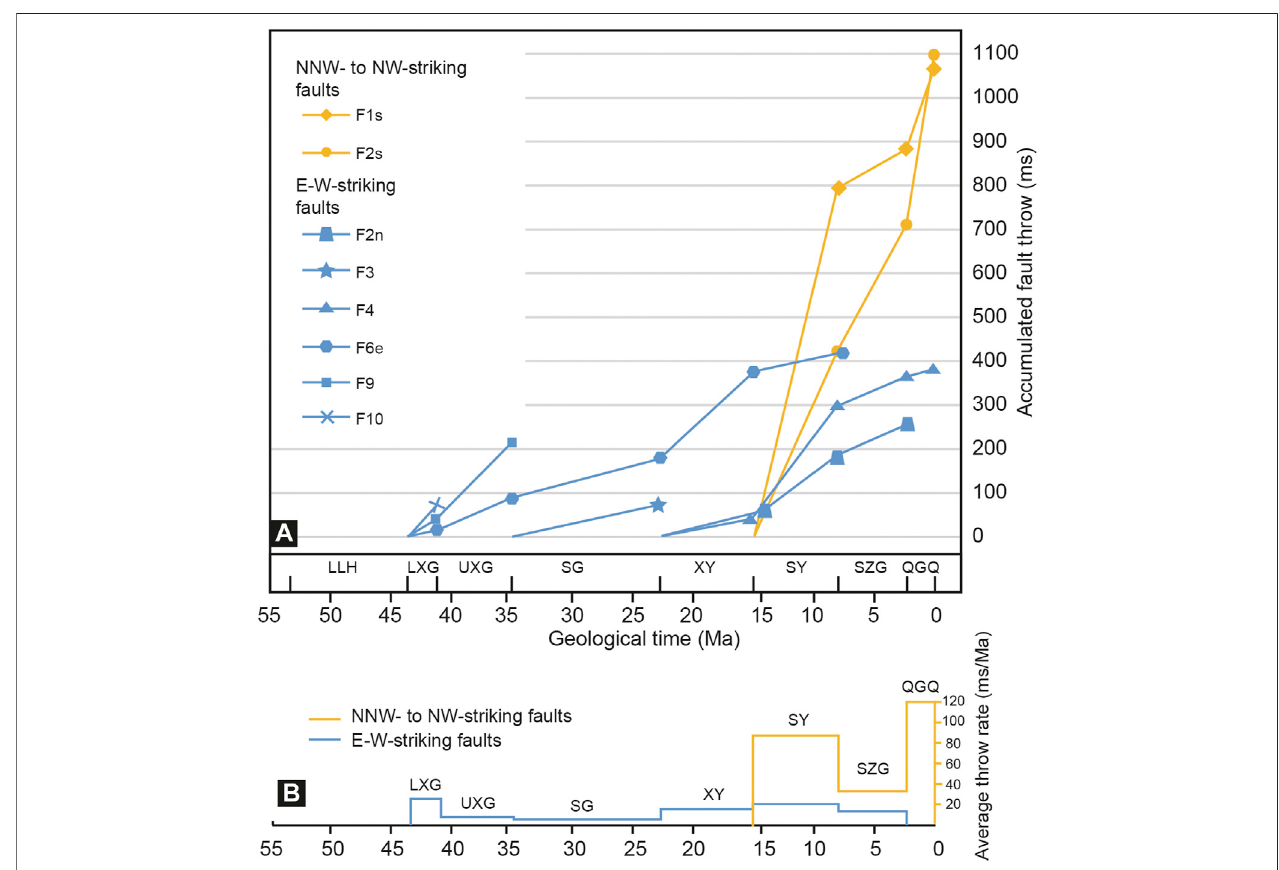
FIGURE 7| Plot ofaccumulated throws (A) and throw rate (B) ofthe basement-involved faults vs. geological time, showing the contrasting temporal development of E-W-striking and NNW- to NW-striking faults.